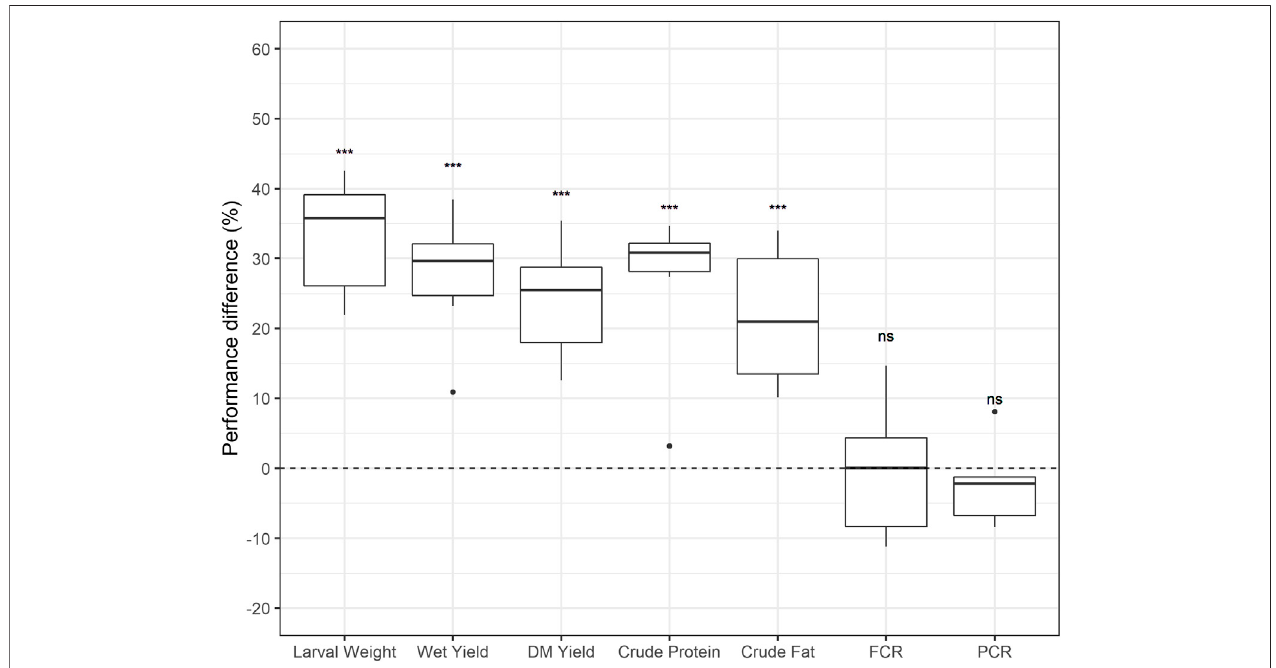
FIGURE3| PerformancedifferencesinaveragecrateoutputsbetweentheBodyweightlineandtheBasepopulationline.Boxplotsrepresentthedistributionofthe resultsfromallthesixroundsforaveragelarvalweight,wetcrateyield,drymatter(DM)crateyield,crudeproteinpercrate,crudefatpercrate,feedconversionratio(FCR) and protein conversion ratio (PCR); ***: p < 0.001, **: p < 0.01, ns: p > 0.05. Note: t -test boxplots per variable available in Supplementary Figure S1 .